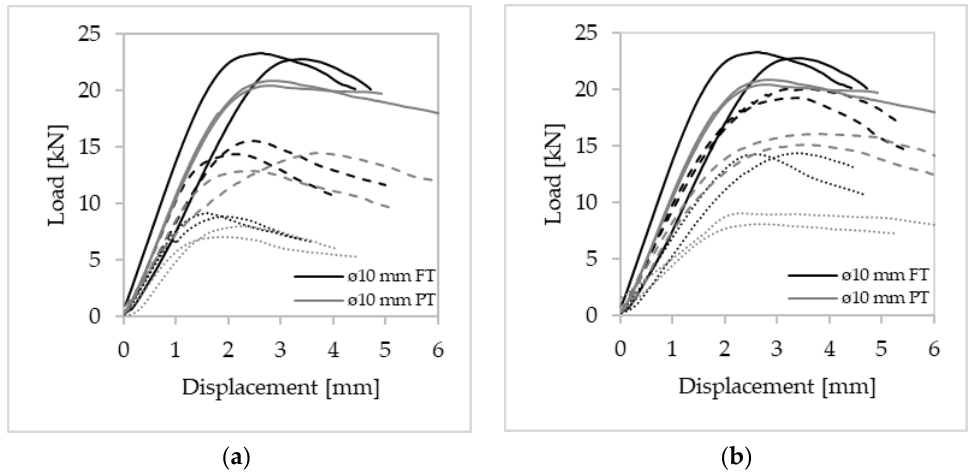
Figure 11. Load-displacement curves for Ø 10 mm screws: ( a ) Exposed head; ( b ) Exposed tip. Solid line for ambient conditions, dashed line for one hour of exposure and dotted line for two hours of exposure.